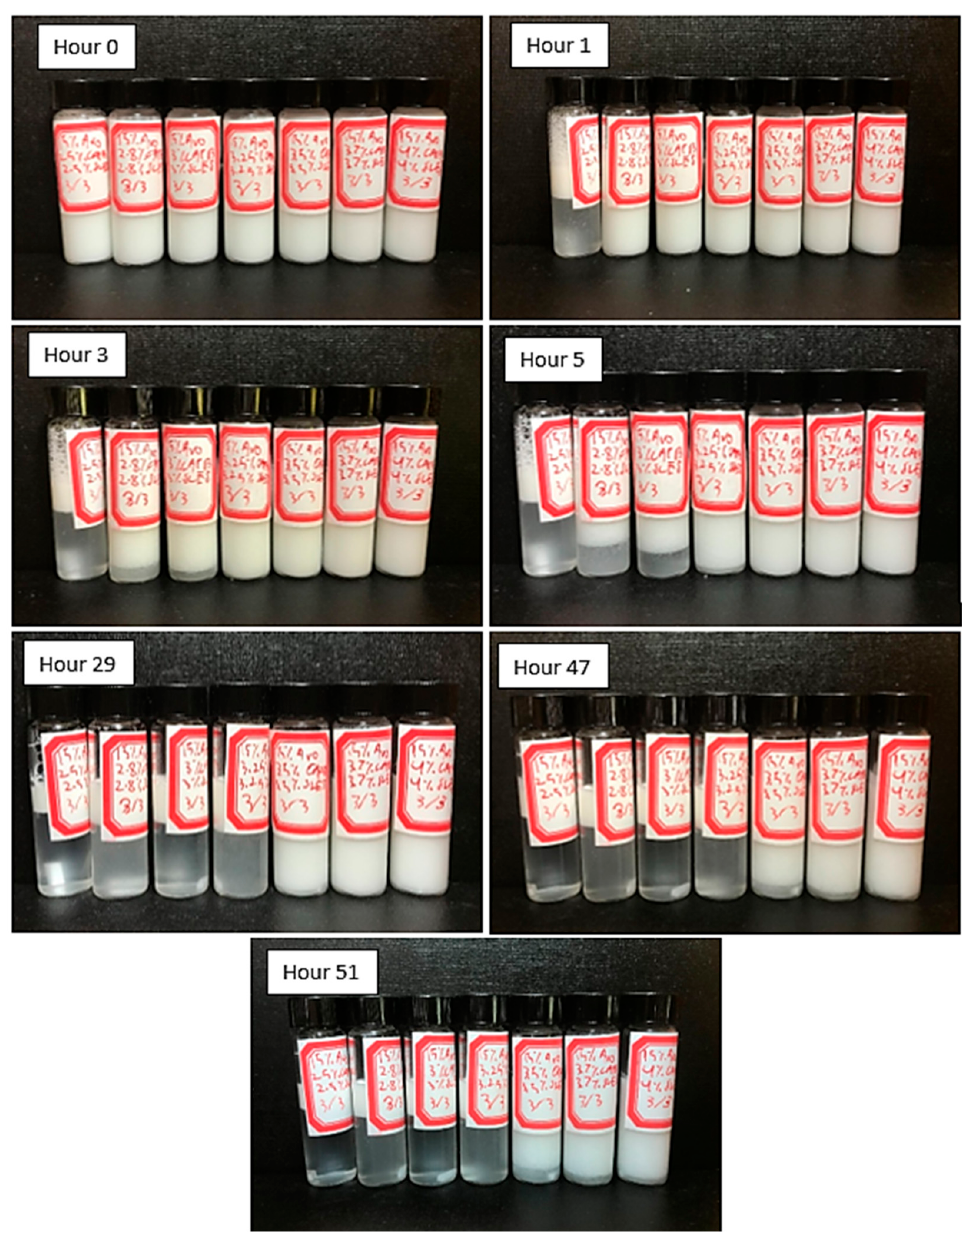
Figure 2. 15 wt % avocado oil emulsions’ visual stability. From left to right samples are 5 wt %, 5.6 wt %, 6 wt %, 6.5 wt %, 7 wt %, 7.4 wt %, and 8 wt % total CAPB and SLES emulsifier concentrations.